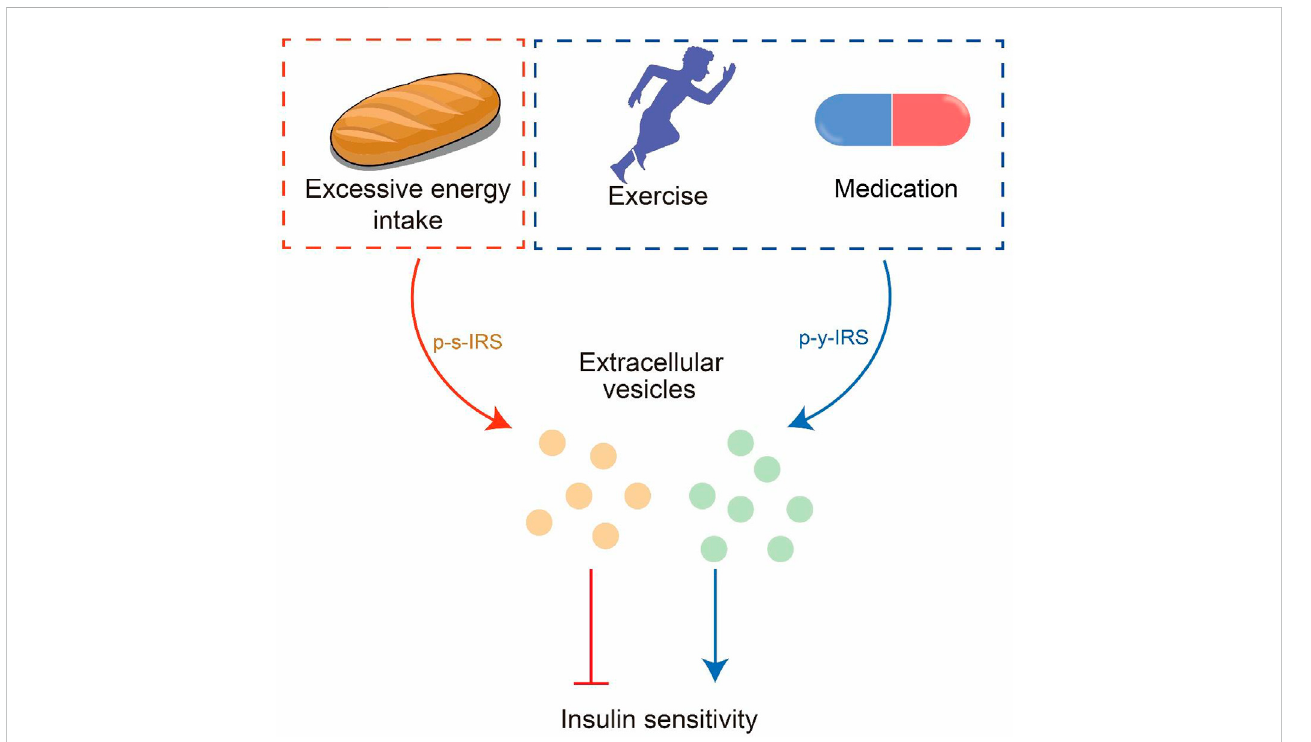
EVs are the information carriers between cells. Excessive energy intake will lead to insulin resistance transmitted through EVs; exercise and meditation can reverse insulin resistance.